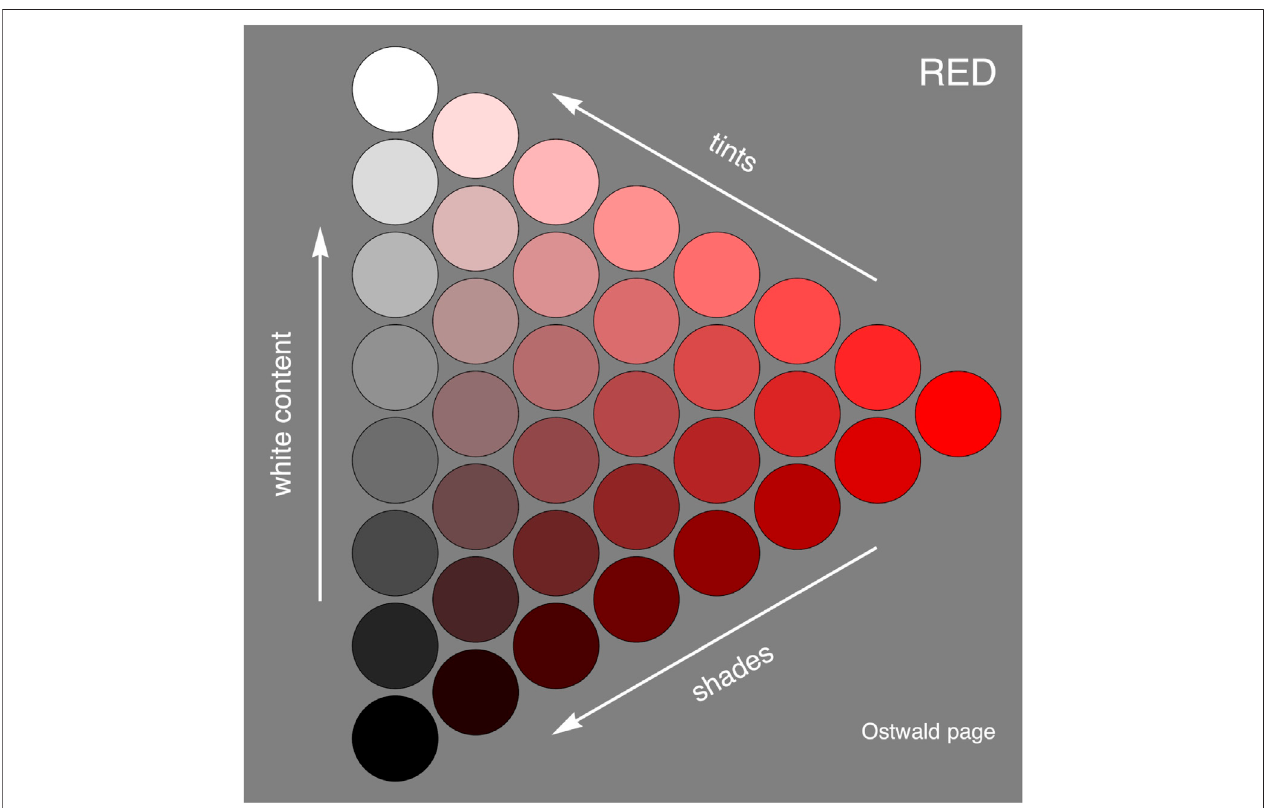
FIGURE 11 | A computed page of the Ostwald atlas. The chips interpolate between the semichrome ( “ full color ” ), black and white. Mixtures with white are “ tints, ” mixtures with black are “ shades. ” Mixtures that include both black and white tend to appear muddy. The idea is that the set of all pages fi lls out the color solid, thus represents all object colors. The shape of the triangle is arbitrarily taken